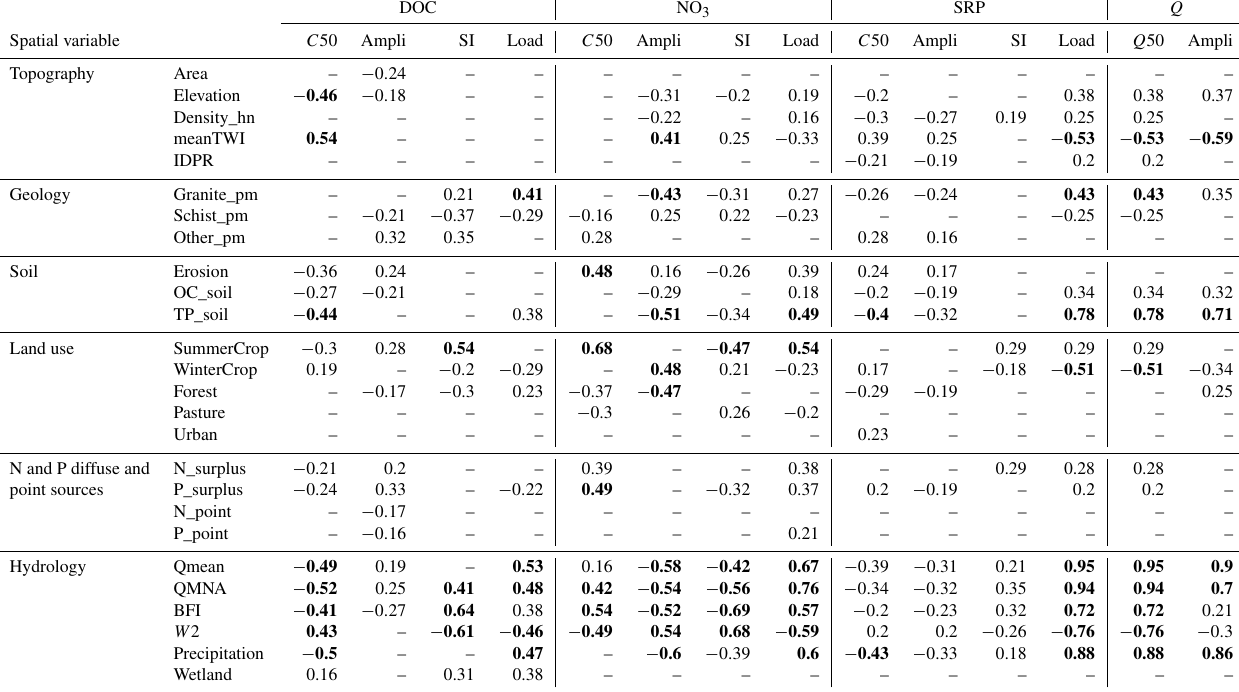
Table 3. Spearman rank correlations between water quality indices for dissolved organic carbon (DOC), nitrate (NO 3 ), soluble reactive phosphorus (SRP), discharge indices ( Q ), and geographical descriptors. Only significant correlations ( p ≤ 0 . 05) are shown, and bold text indicates | r | ≥ 0 .